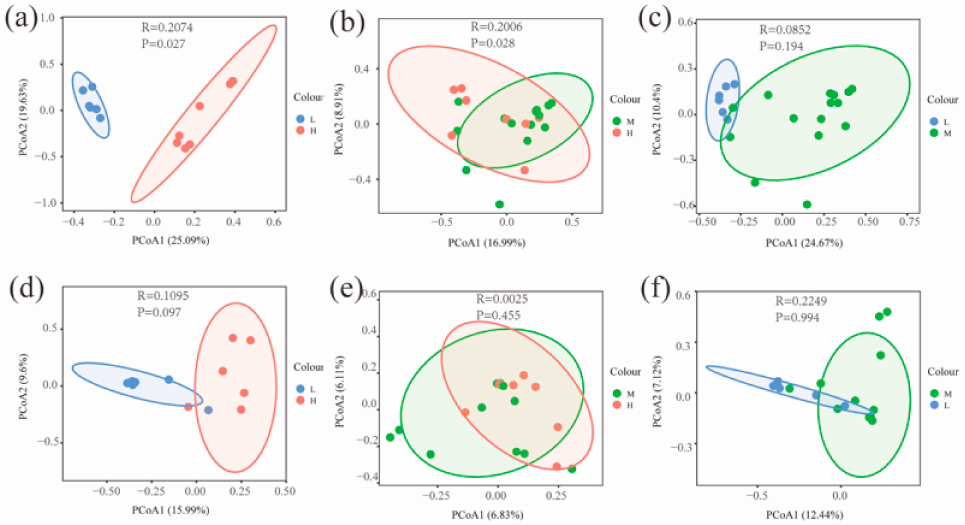
Figure 5. Beta diversity of soil microorganisms at different water-salt gradients. Note: H, M and L denote high, medium and low water-salt gradients, respectively; ( a – c ) represent PCoA analysis between different water-salt gradients of the bacterial communities; ( d – f ) represent PCoA analysis between different water-salt gradients of the fungal